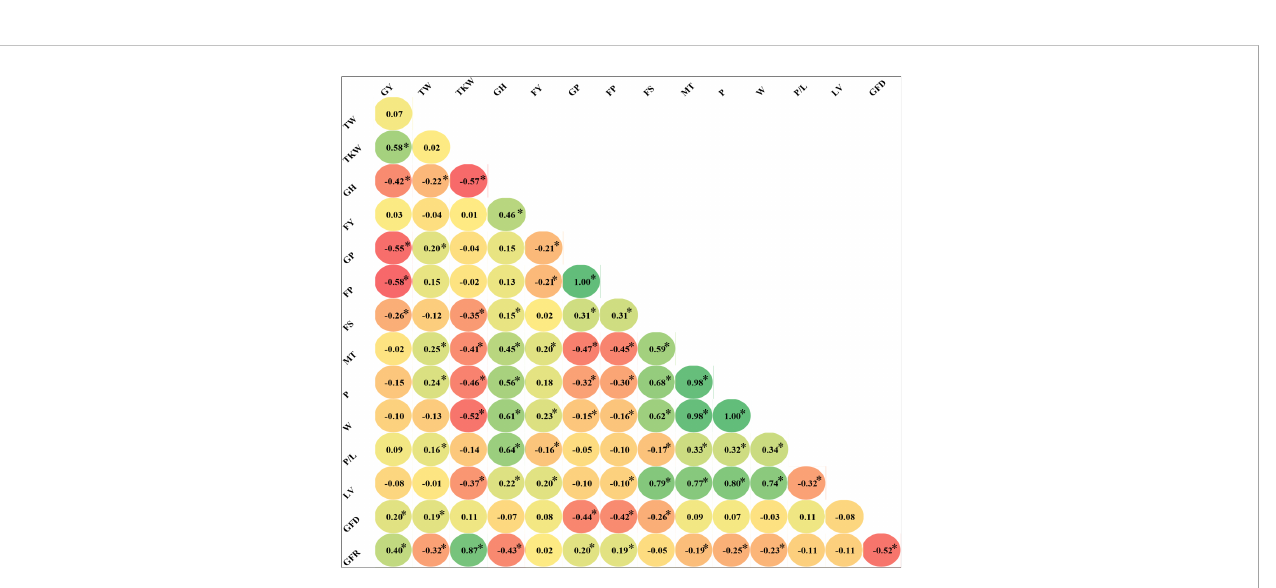
FIGURE 2 Correlations between bread wheat quality traits measured in a population of Landraces (average of two cropping seasons). Signi fi cant Pearson correlation coef fi cients at p ≤ 0.05 are highlighted with *.Traits, P/L,alveograph tenacity/extensibility ratio; W, Elasticity or strength (J*10 -4 ); GFD, Duration of grain fi lling (days); FP Flour Protein (%); FS, Sedimentation test (mL); FYL, Flour Yield(%); GH, Grain hardness; GP, Grain protein (%); LV, Loaf Volume(mL); MT, Mixing time of dough (min), P, Torque peak (%Torque*min); GFR, Rate of grain fi lling (mg day -1 ); TKW, Thousand kernel weight (g); TW, Test weight (kg hL -1 ); GY, Grain yield (t ha -1